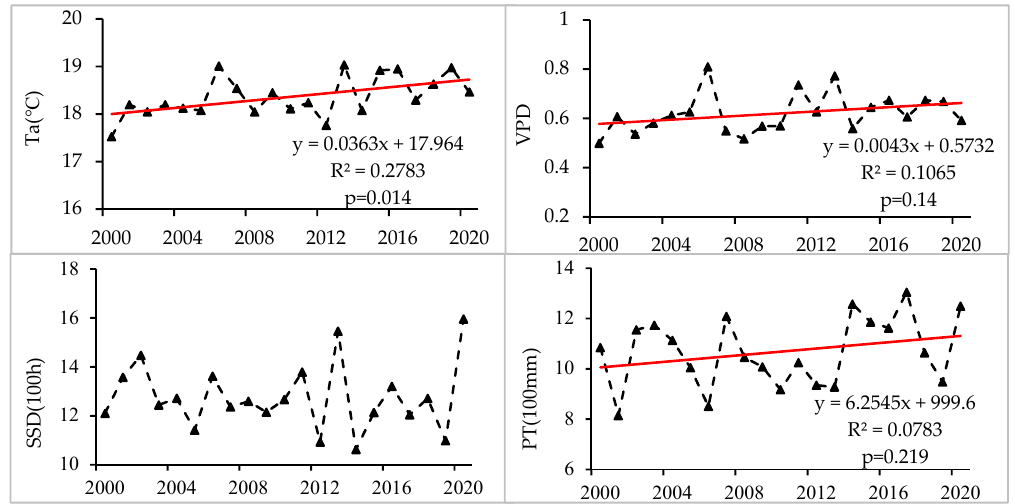
Figure 8. Interannual variation of the four dominant factors (Ta, VPD, SSD, and PT).